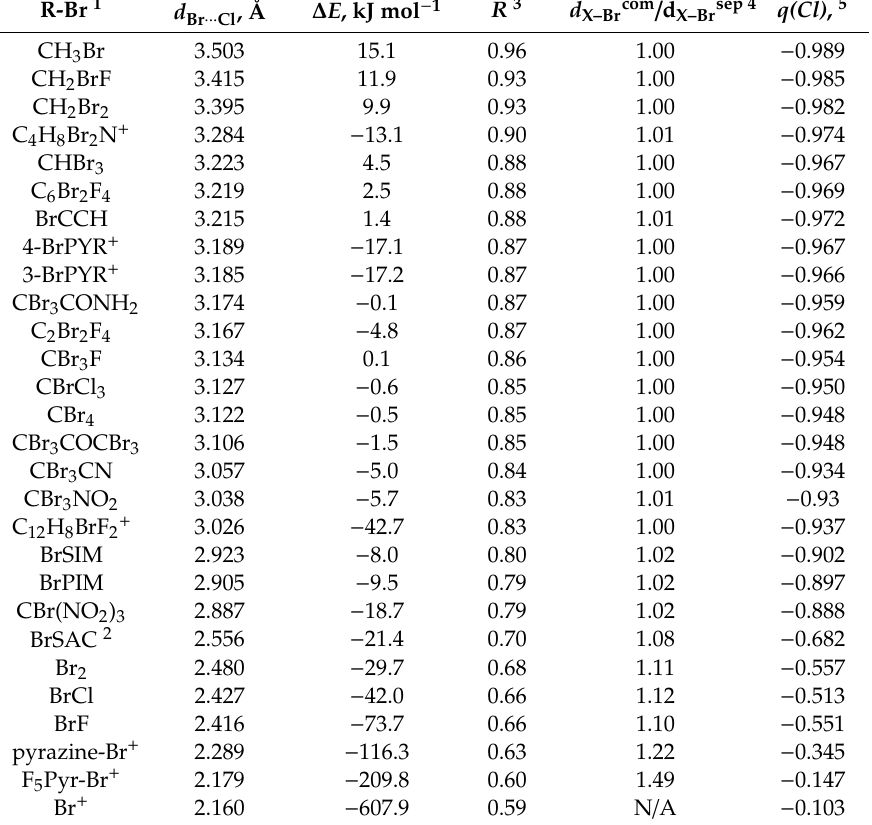
Table 2. Characteristics of the calculated R–Br · Cl −